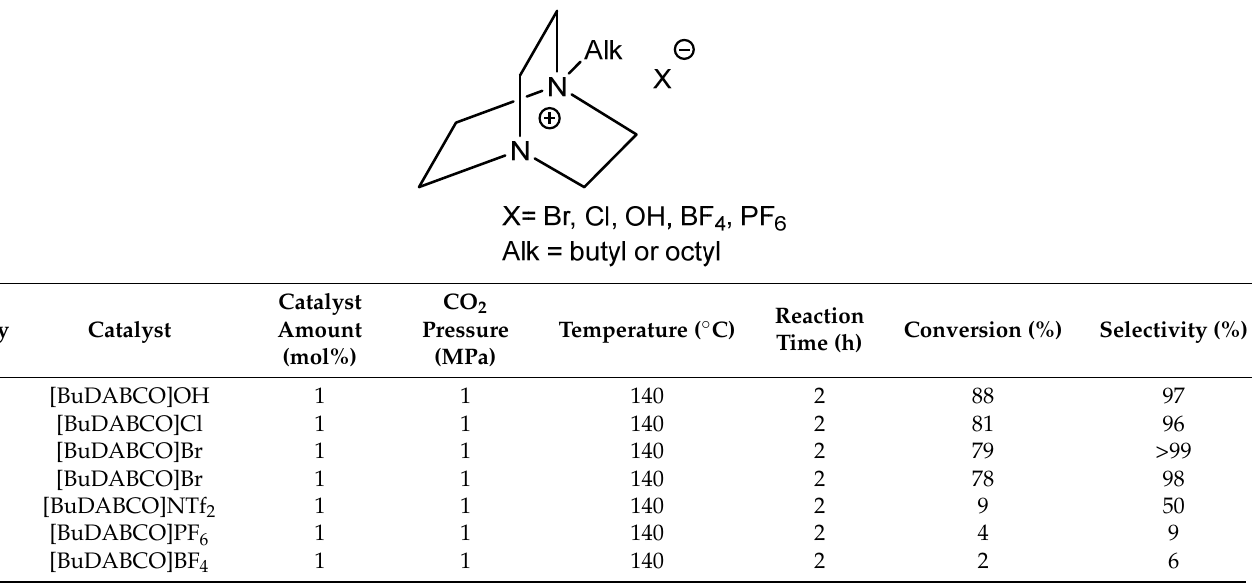
Table 12. PC synthesis catalyzed by DABCO-based Lewis basic ionic liquids [29].